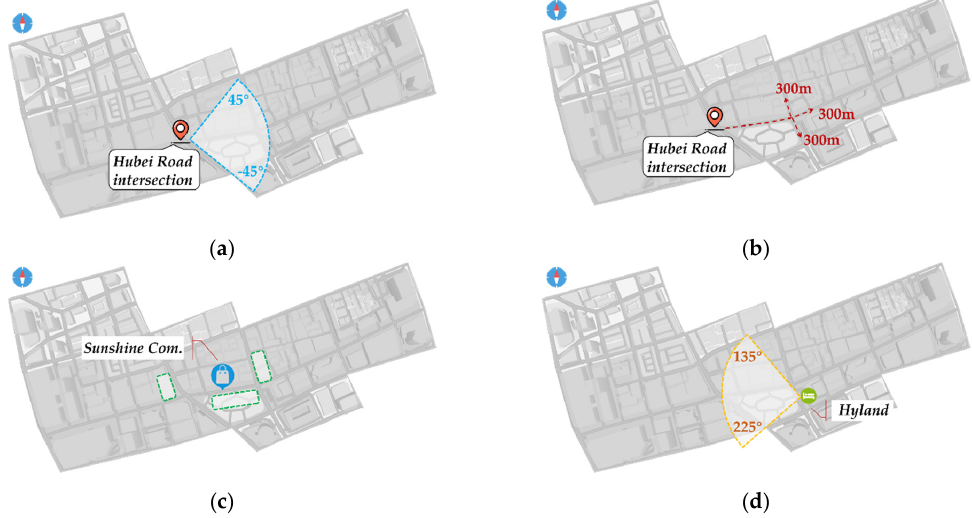
Figure 11. Positioning results of each compound spatial assertion. ( a ) is the schematic diagram of the direction relation with Hubei road intersection as the reference. ( b ) is the schematic diagram of the distance relation with Hubei road intersection as the reference. ( c ) is the schematic diagram of the distance and direction relations with Sunshine commercial building as the reference. ( d ) is the schematic diagram of the direction relation with Hyland hotel as the reference.